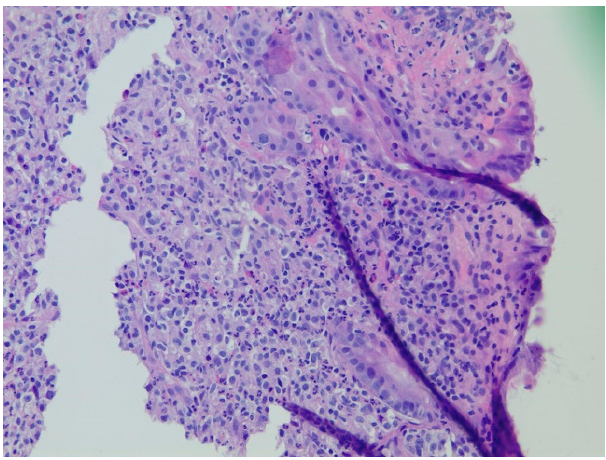
Figure 9. Predominantly small to medium-sized lymphocytes with pale cytoplasm (centrocyte-like) with slightly irregular nuclear contours with inconspicuous nucleoli and relatively abundant cyto- plasm concerning for lymphoma noted on hematoxylin and eosin stain at 200× magnification.